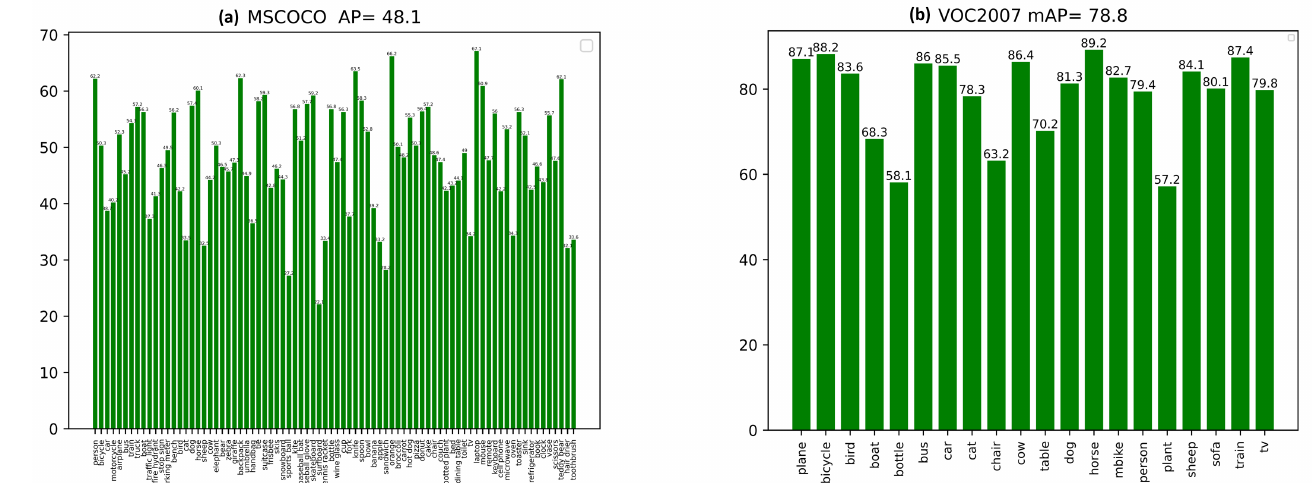
Figure 9. ( a ) The obtained evaluation mAP value of each class of PASCAL VOC2007 test set and the overall mean AP value at IOU of 0.5; ( b ) the AP box value for each class MS-COCO minival and the overall mean value of AP box .